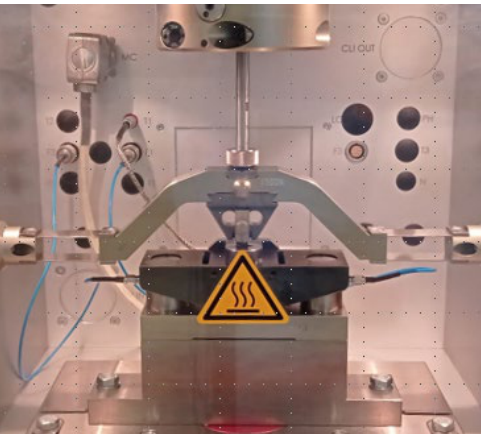
Figure 2. SRV5 tribometer overview.